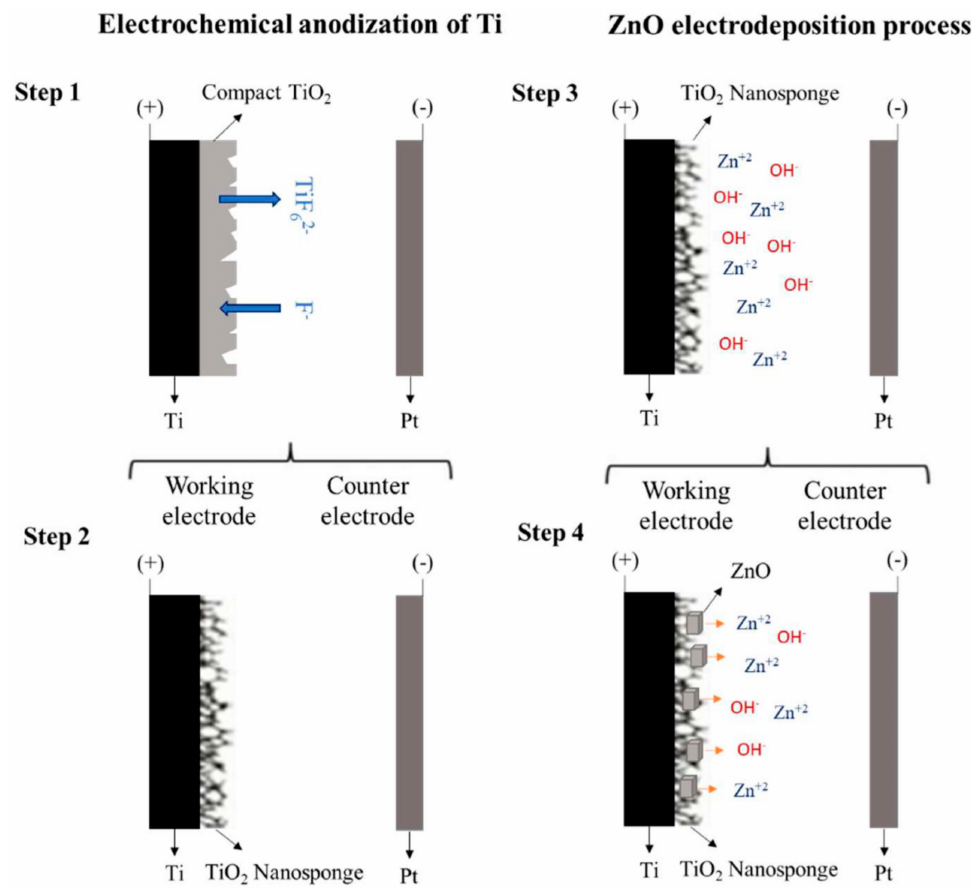
Figure 2. Schematic diagram of growth mechanism of TiO 2 and